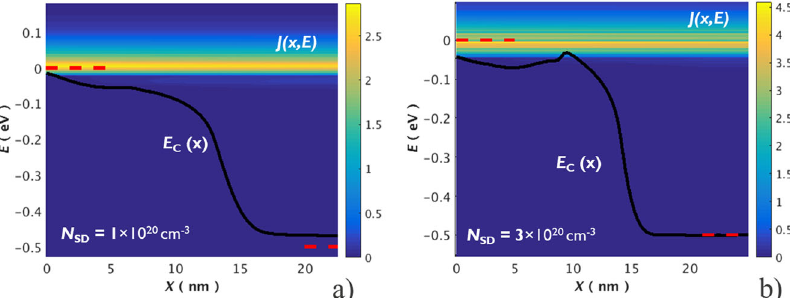
Fig. 7 Impact of source and drain doping on internal properties of a 2D MOSFET in on-state. Current spectrum J(E, x) (surface plot), as well as top conduction-band ( E C ) (-) edge along the channel direction, x , of the L = 5 nm HfS 2 nMOS in on-state. a For N SD = 1 × 10 20 cm − 3 . In this case, due to the lower N SD value, the current fl ow is limited by the source conduction band and source starvation is observed in the I D ( V G ) characteristics. b For N SD = 3 × 10 20 cm − 3 . In this case, the current is still limited by the channel barrier that is well controlled by the gate. Current saturation is not yet observed in the characteristics at this gate voltage. V D = 0.5 V. V G = 0.6 V.